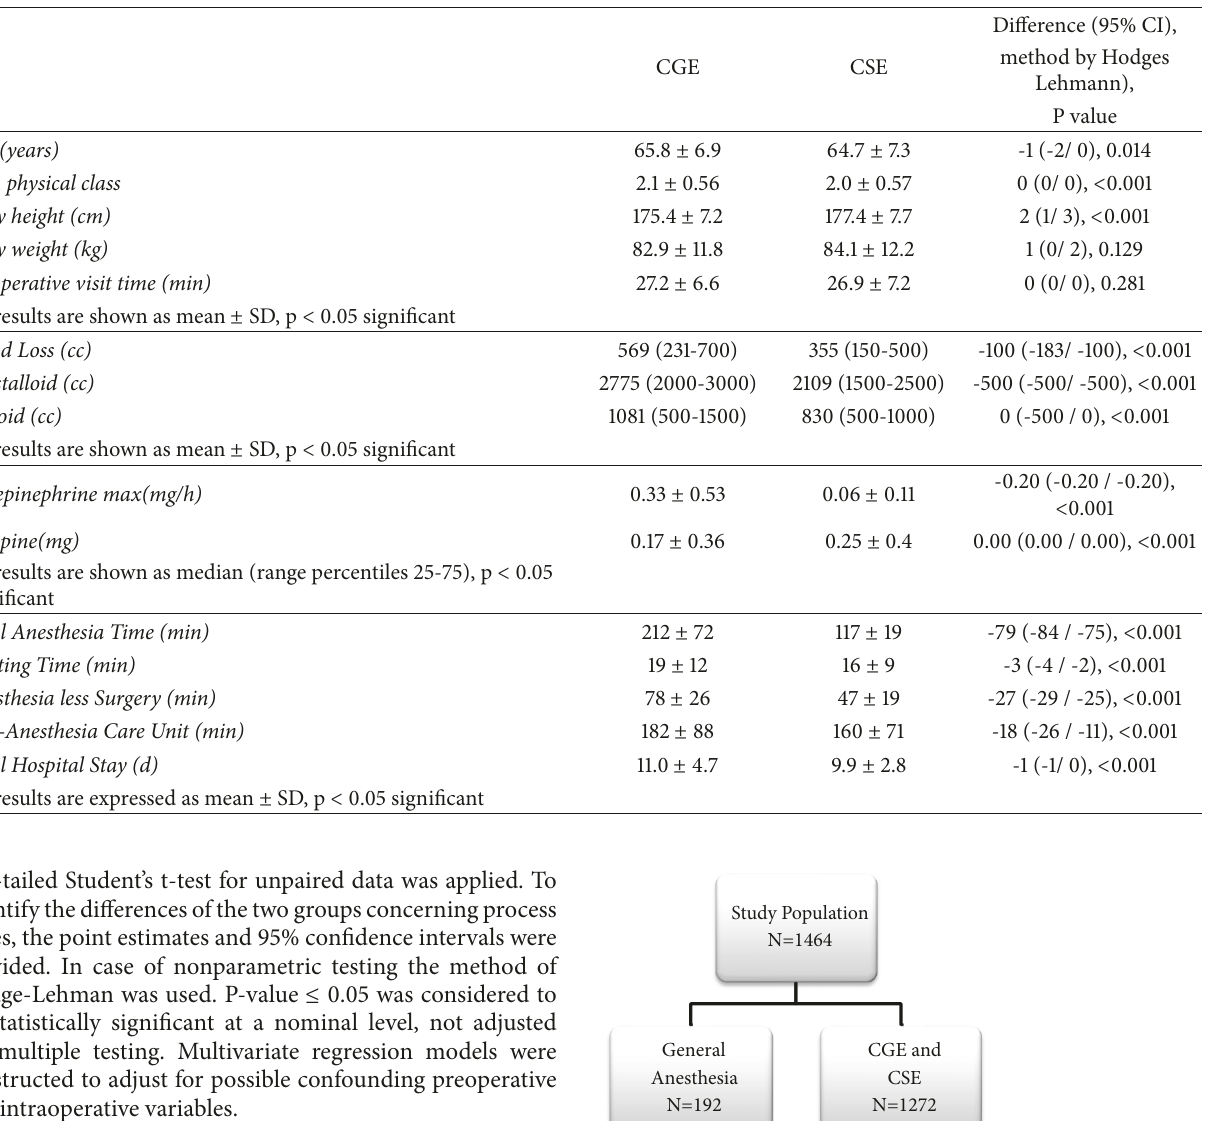
Table 1: Perioperative parameters.